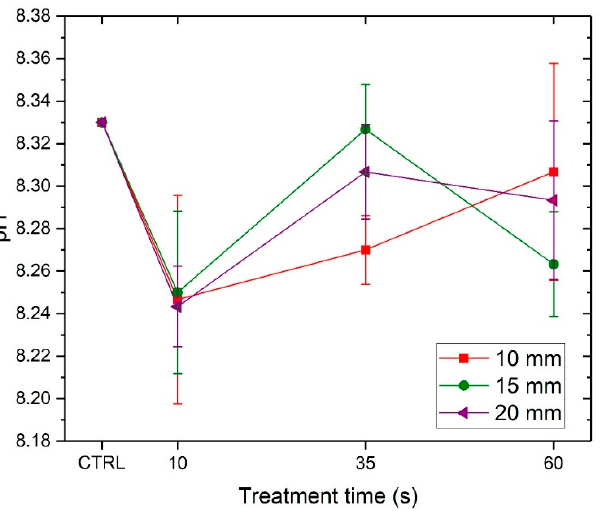
Figure 4. pH of plasma treated MEM measured right after treatment. Results are presented as mean values ± SEM (two- way ANOVA, Dunnett’s post-tests; n =